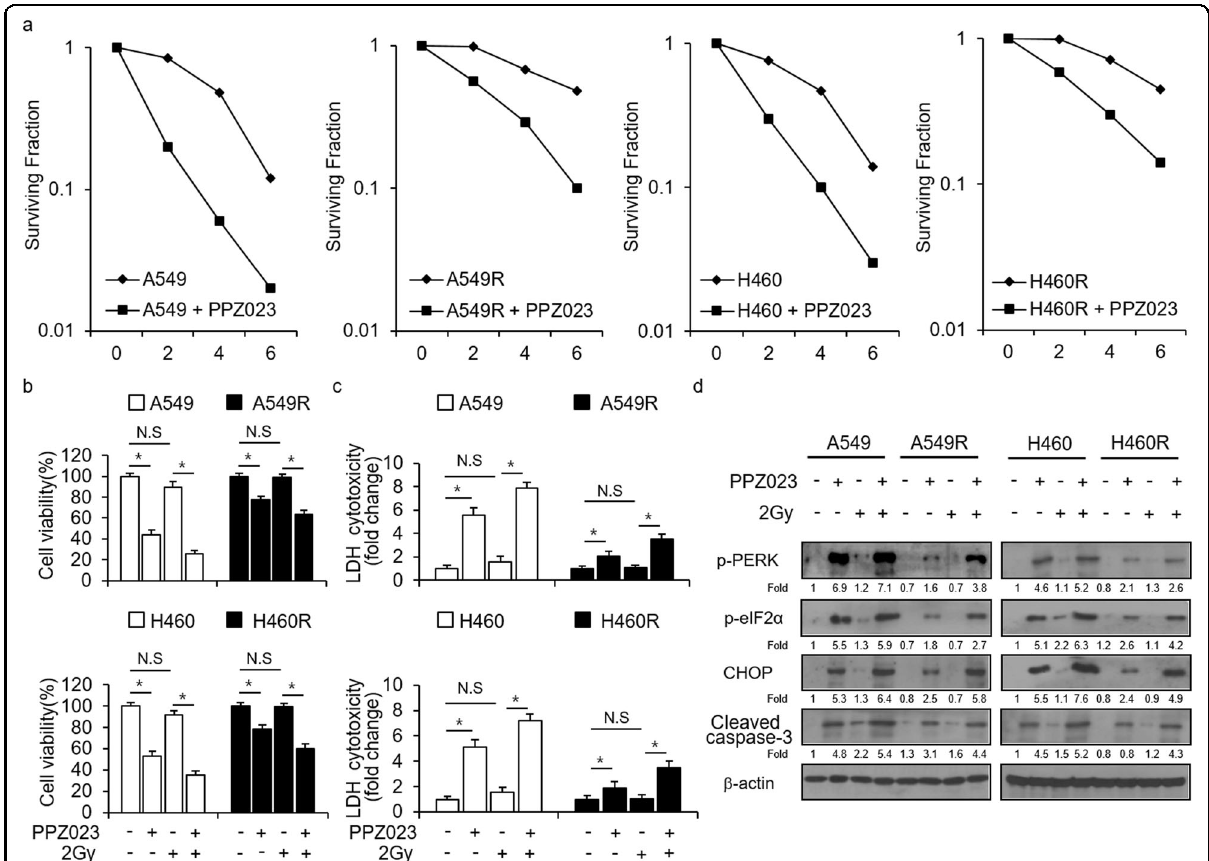
Fig. 7 PPZ023/2Gy induces cell death via ER stress in radioresistant NSCLC cells. a A clonogenic cell survival assay was conducted after PPZ023 (25 μΜ , 24 h) treatment and exposure to various radiation doses (2, 4, or 6 Gy). The survival fraction in A549, H460, A549R, and H460R cells was calculated using the surviving fraction formula; * p < 0.05. b – d A549, H460, A549R, and H460R cells were treated with PPZ023 (25 μΜ , 24 h) after exposure to 2 Gy radiation. Cell viability and LDH assays were performed along with western blot analyses of p-PERK, p-eIF2 ɑ , CHOP, and cleaved caspase-3. β -Actin was used as the protein loading